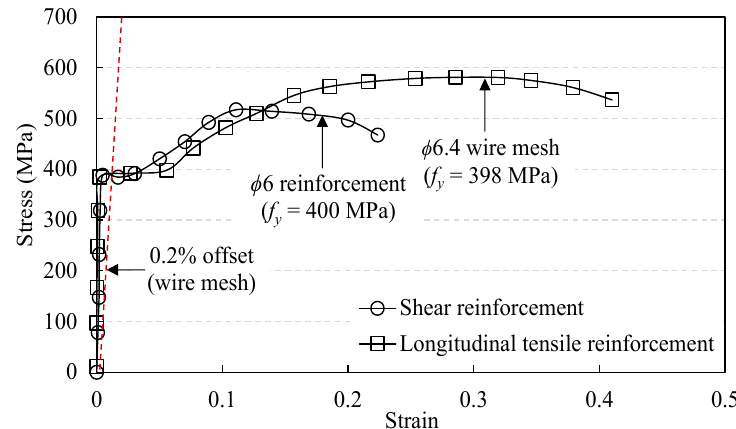
Figure 2. Stress–strain curves of reinforcing bars.